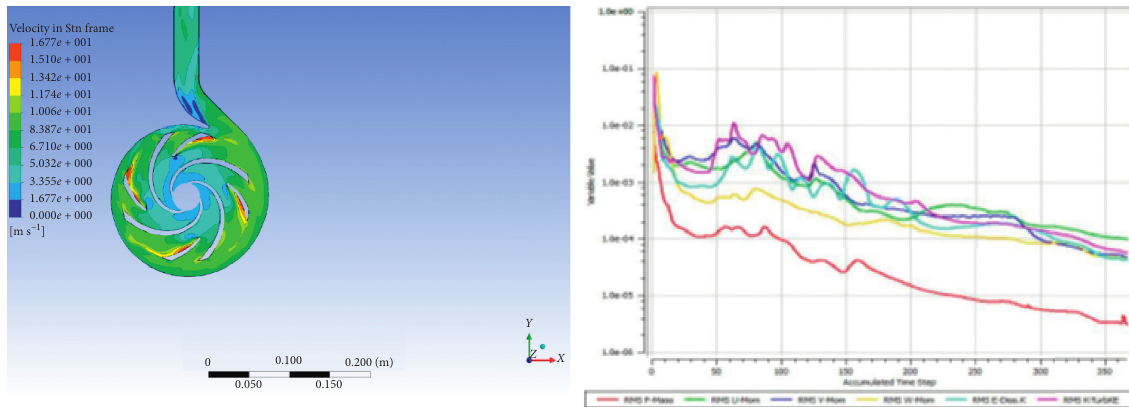
Figure 2: Simulation tool screenshots.